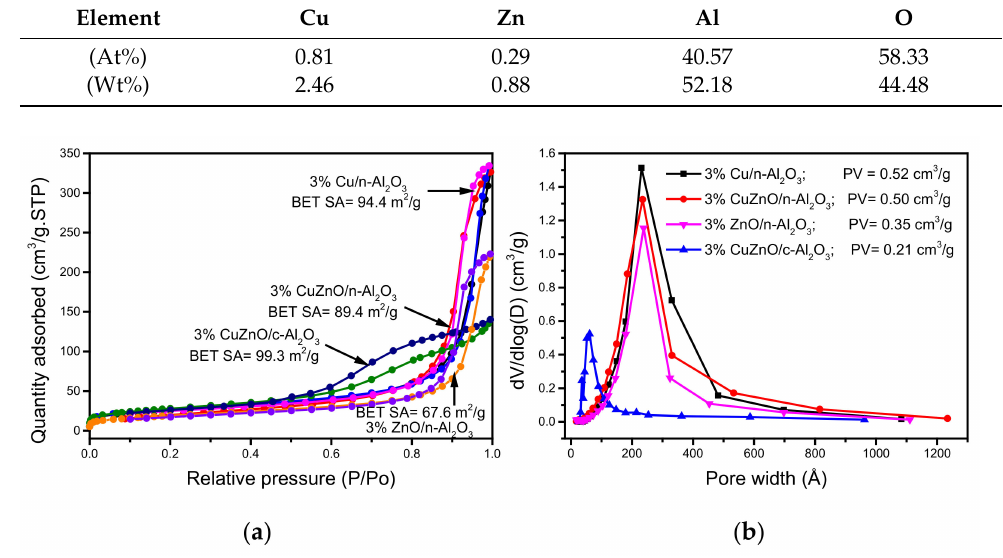
Table 1. EDX analysis of the 3% CuZnO/n-Al 2 O 3 catalyst.